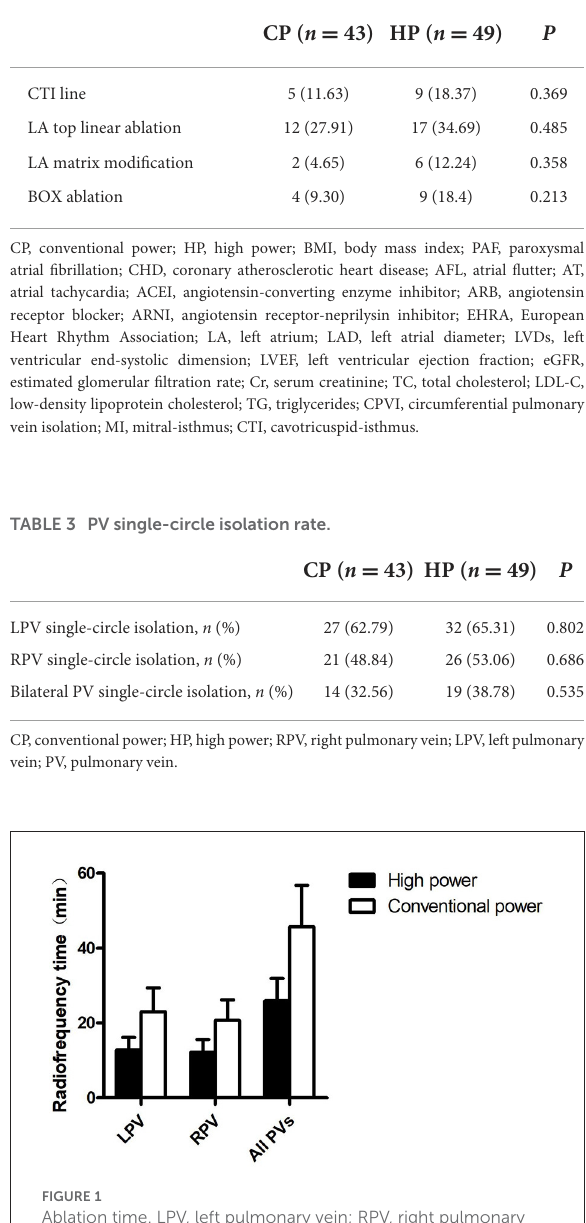
in the CP group. There was no significant difference in the incidence of pops between the two groups (4.08% vs. 0.00%, P = 0.533). No operational complications such as pericardial effusion/tamponade, stroke/transient ischemic attack, thromboembolic events, PV stenosis, atrioesophageal fistula, phrenic nerve injury, and vascular complications (e.g., arteriovenous fistula and pseudoaneurysm) occurred during the